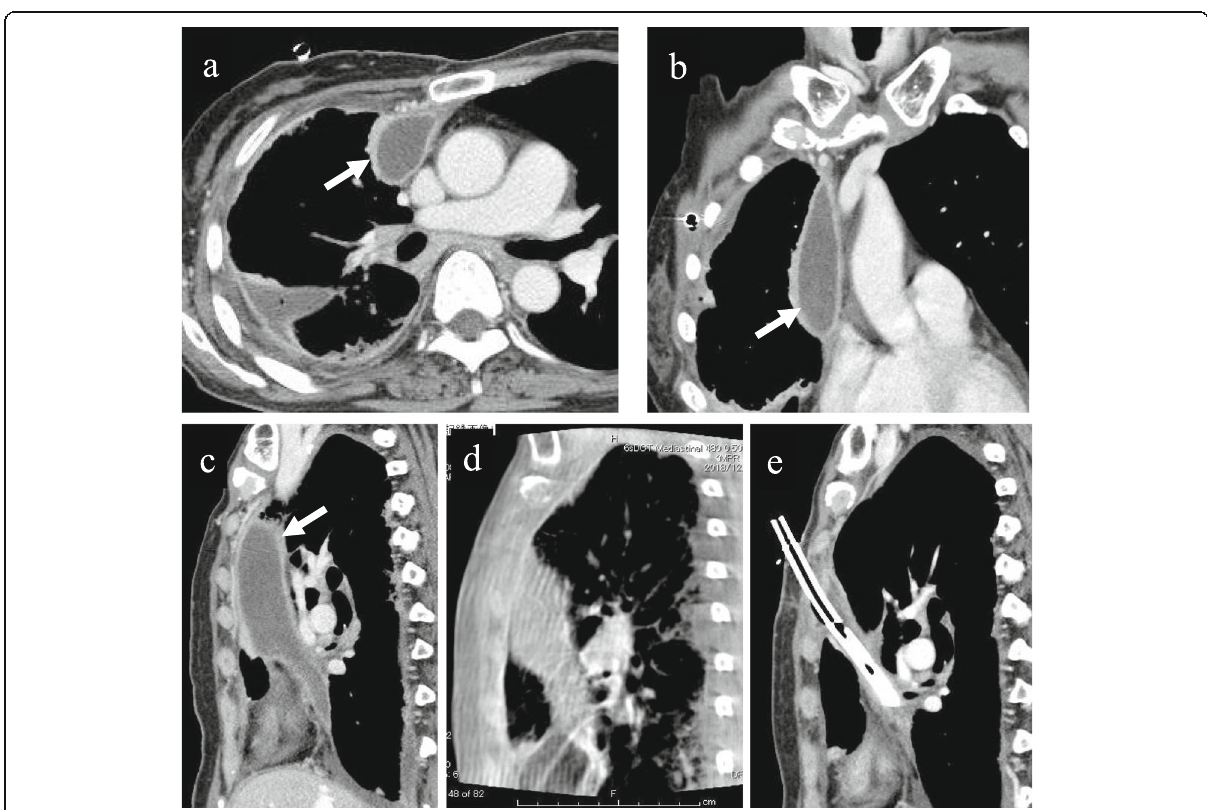
Fig. 2 Cavity I: This cavity was from the ventral side of the superior vena cava in the anterior mediastinum to the inferior pulmonary vein along the pericardium. Axial view ( a ), coronal view ( b ), and sagittal view ( c ) of chest CT findings at admission. Intraoperative CBCT before ( d ) and after ( e ) the debridement and drainage of the organized empyema cavity. This empyema cavity was only in a narrow range with the chest wall, and it was located on the back of cost rib cartilage. Thus, we determined the location of skin incision using